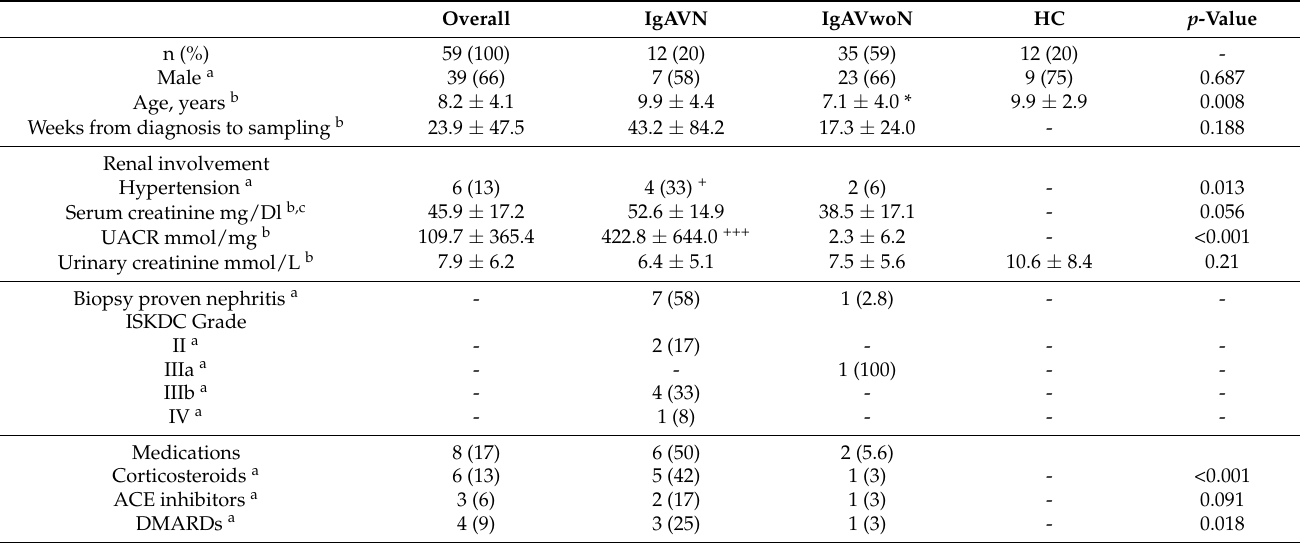
Table 1. Patient characteristics at